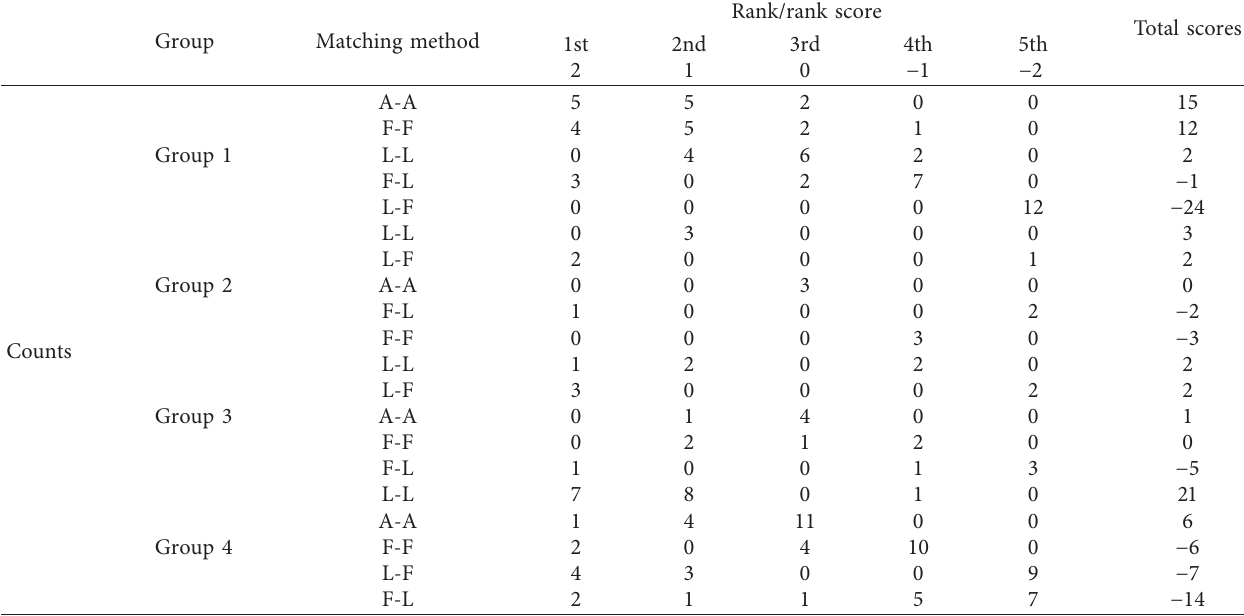
Table 4: Ranking and scoring to evaluate the performance of different matching